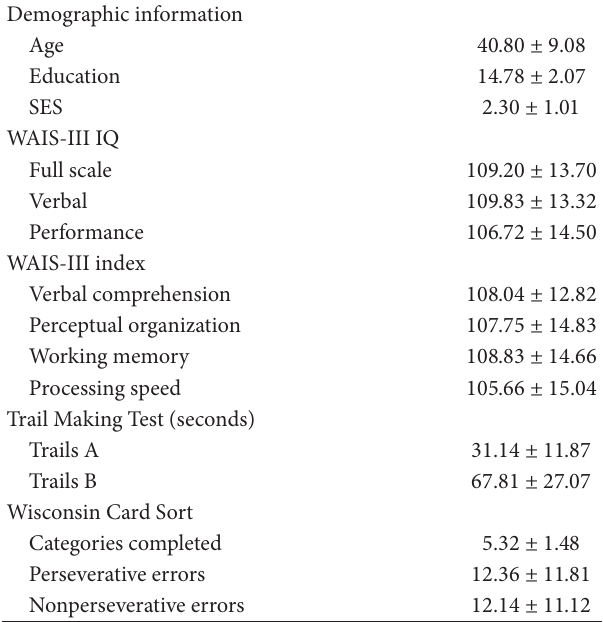
Table 1: Neuropsychological scores for research